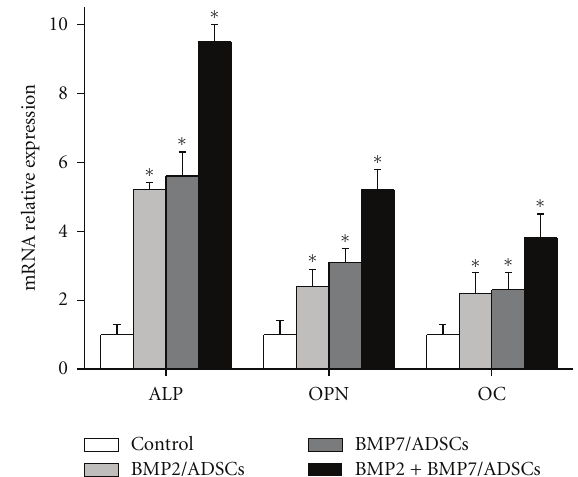
Figure 4: The mRNA-relative expression analysis of osteogenic marker genes ALP, OPN, and OC in control, BMP2/ADSCs, BMP7/ADSCs, and BMP2 + BMP7/ADSCs groups. Results are shown as mean ± SD ( n = 3 for each group, ∗ P < 0 .